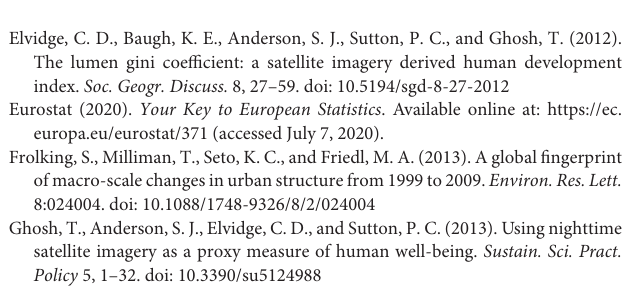
Figure S1 | Census tract and raster cell representation of BVPC for Sacramento, California. Figure S2 | Census tract and raster cell representation of BVPC for Modesto, California. Figure S3 | Census tract and raster cell representation of BVPC for Fresno, California. Figure S4 | Census tract and raster cell representation of BVPC for Santa Barbara, California. Figure S5 | Census tract and raster cell representation of BVPC for San Francisco, California. Figure S6 | Census tract and raster cell representation of BVPC for Bakersfield, California. Figure S7 | Census tract and raster cell representation of BVPC for Fullerton, California. Figure S8 | Census tract and raster cell representation of BVPC for Los Angeles,